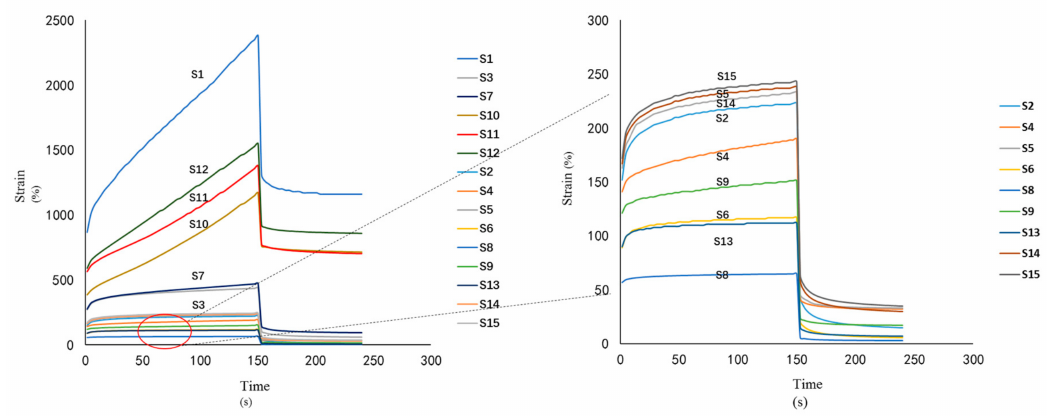
Figure 6. Strain–time plots at constant stress level applied to the samples